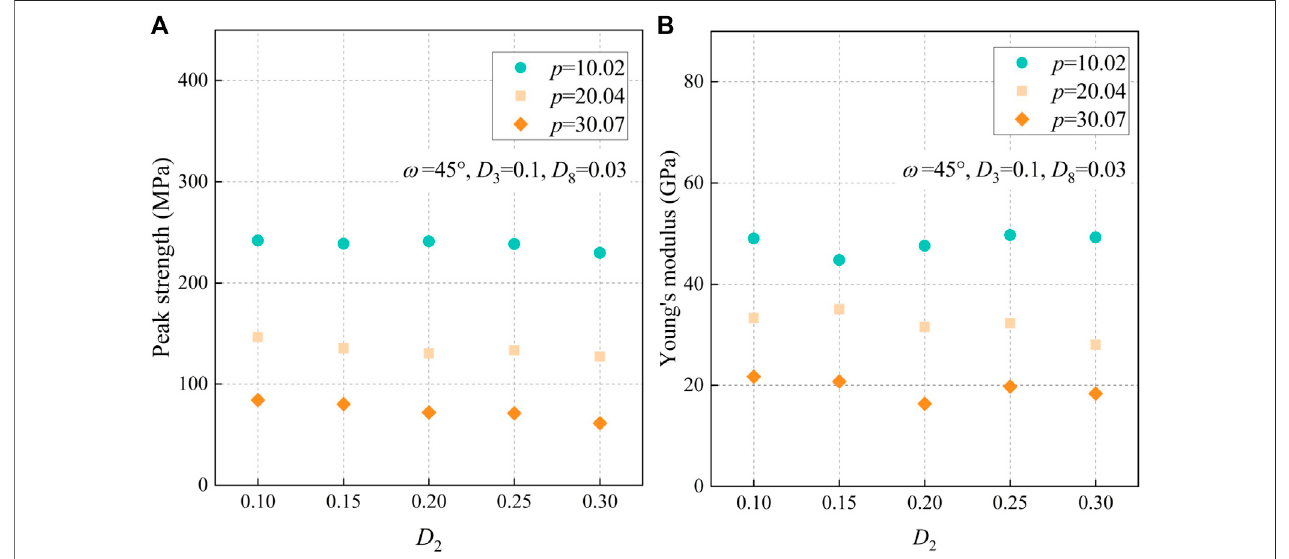
FIGURE 11 | Results of (A) compressive peak strength; and (B) corresponding Young ’ s modulus for groups D2-P-1, D2-P-2, and D2-P-3.